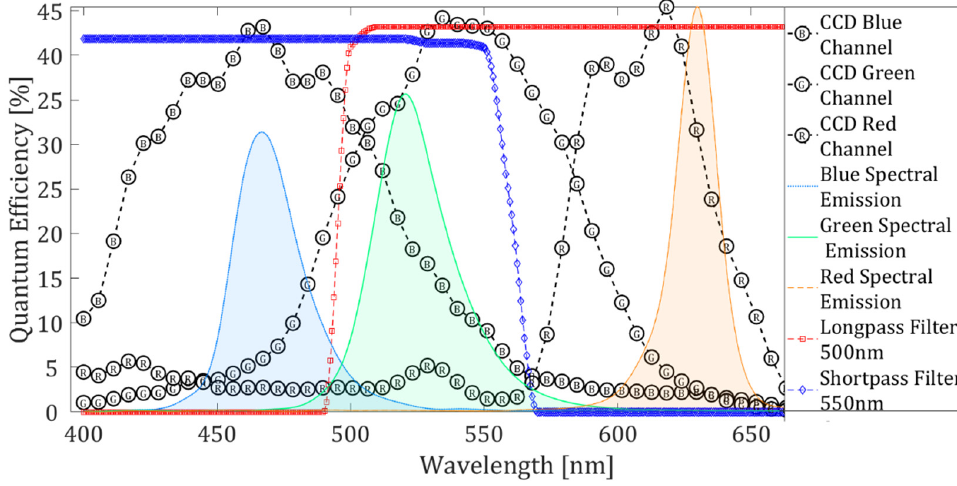
Figure 2. Relation between the spectral responses of the color digital camera, rgb LED, and shortpass and longpass filters.